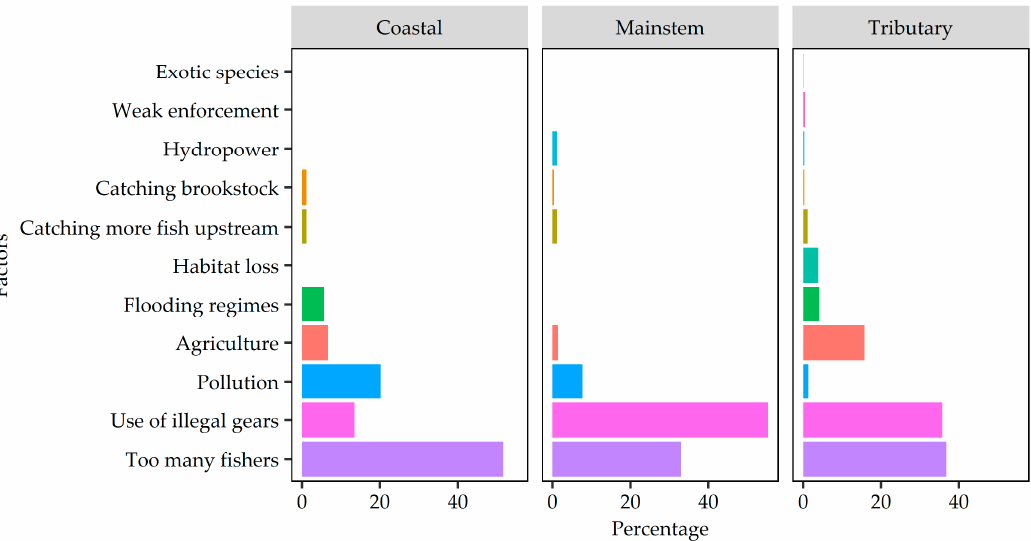
Figure 4. Perspectives of fishers on the main factors contributing to perceived declines in fish catches in the Mekong Delta.